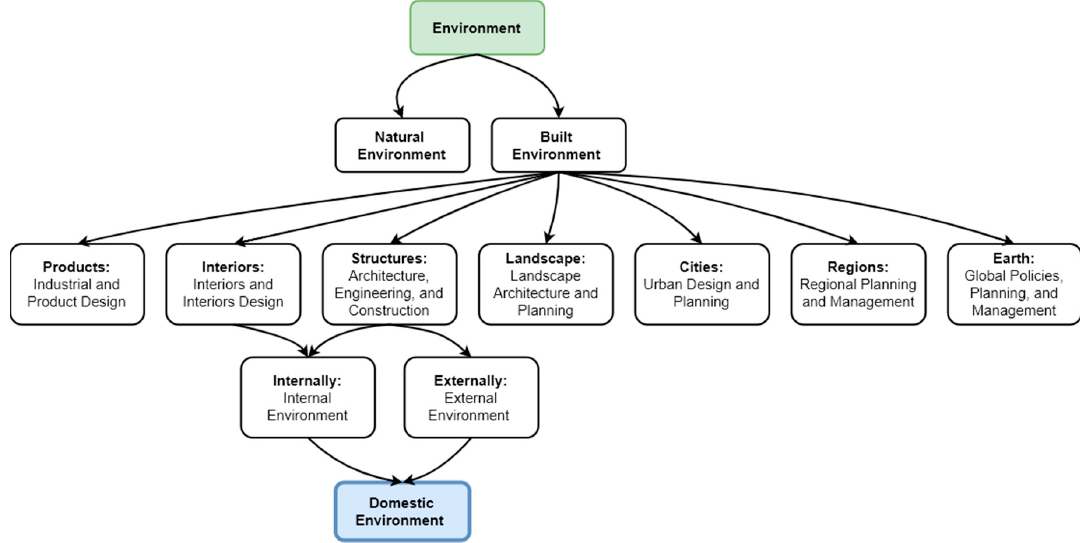
Figure 2. Multidisciplinary domains within built environment [13,16,20,21].